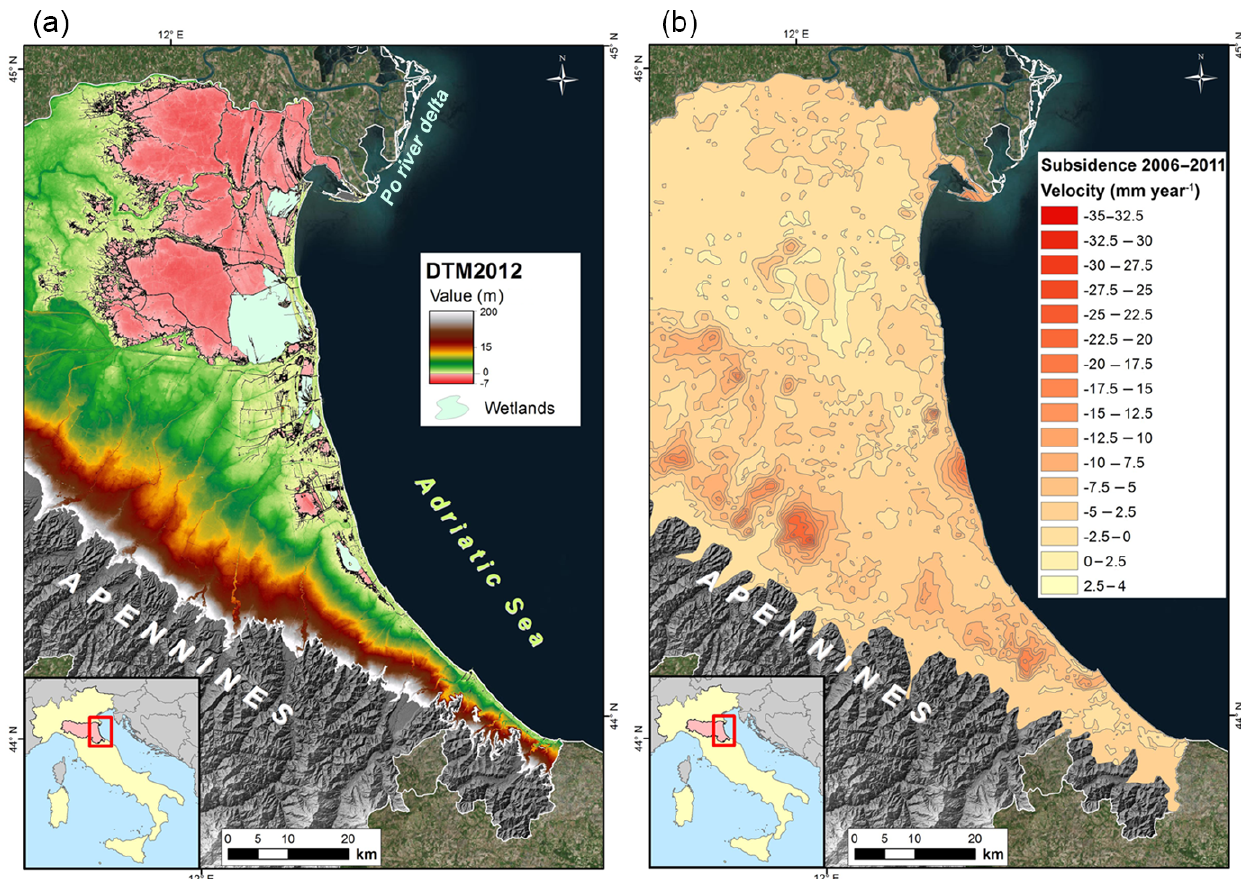
Figure 2. (a) The altimetry and morphology of the E-R coastal plain resulting from a high-resolution digital terrain model (DTM). The reference height in the map is the zero of the Italian geodetic network. The remarkable difference between the N and the S sectors in terms of the extension of lowlands is evident. (b) Subsidence rate map of the E-R coastal plain according to the interferometric synthetic aperture radar (InSAR) monitoring for the time period 2006–2011 (Bissoli et al., 2012).